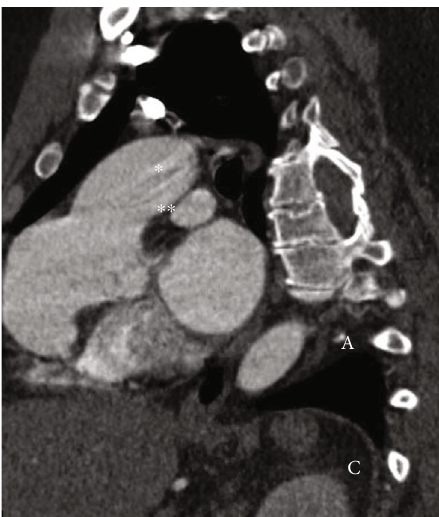
Figure 1: Transverse computed tomography angiography view of the aneurysm with a 2-dimensional diameter of 4.7cm at the level of sinotubular junction.